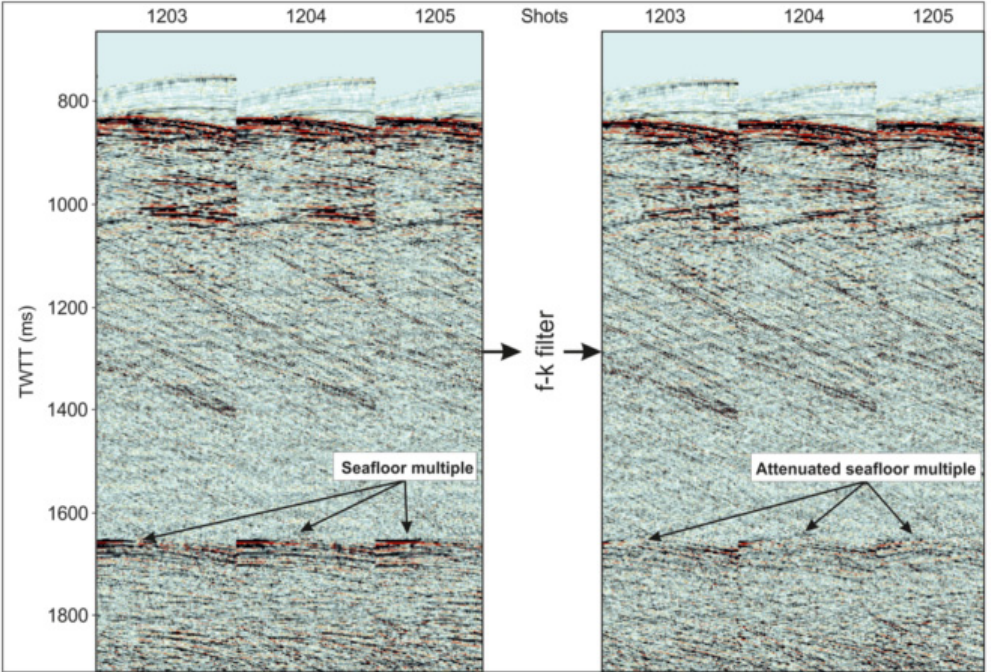
Figure 12. Comparison between three not fk-filtered (left) and fk-filtered (right) shots of the L_I01_HR seismic section (Ionian Sea). Note the seafloor multiple attenuation (see text for further